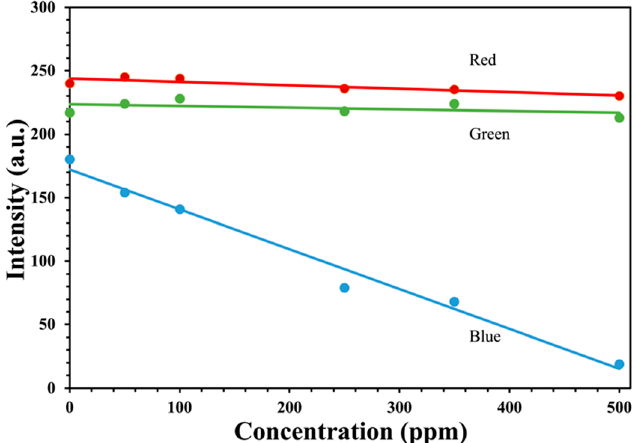
Figure 4. The red, green, and blue decomposition and intensities from reflected images of XploSafe PS test-strips after exposure to various concentrations of solution phase hydrogen peroxide. The color of the lines and markers represents each individual color channel.